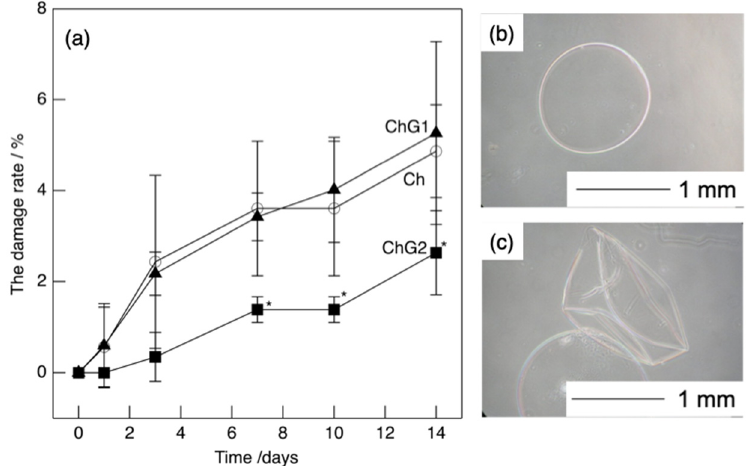
Figure 4. The damage rate of the chitosan–GPTMS–CMC capsules ( a ) and microscopy images of the ChG2 capsules before shaking ( b ), and after damage at 14d ( c ). * p < 0.01.